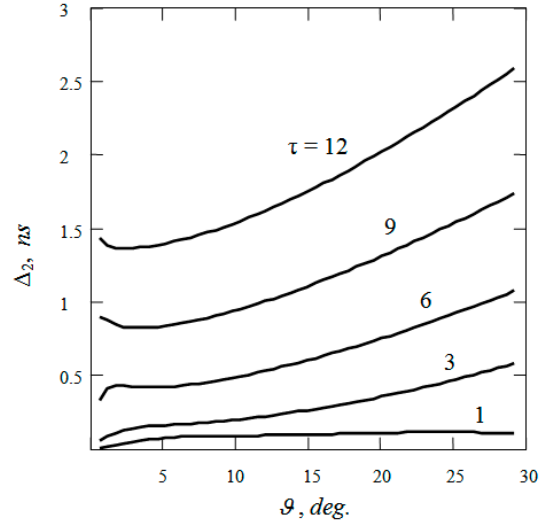
Figure 3. The delay of the “center of gravity” of the pulse ∆ 1 = t − ( r / c w ) (in nanoseconds) because of the scattering of light in water depending on the angle ϑ at various optical distances τ (indicated by the numbers in the figure); c = 0.4 m − 1 .